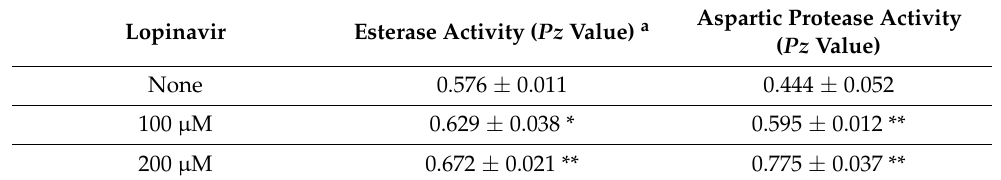
Table 3. Effects of lopinavir on the production of extracellular hydrolytic enzymes by C. albicans .